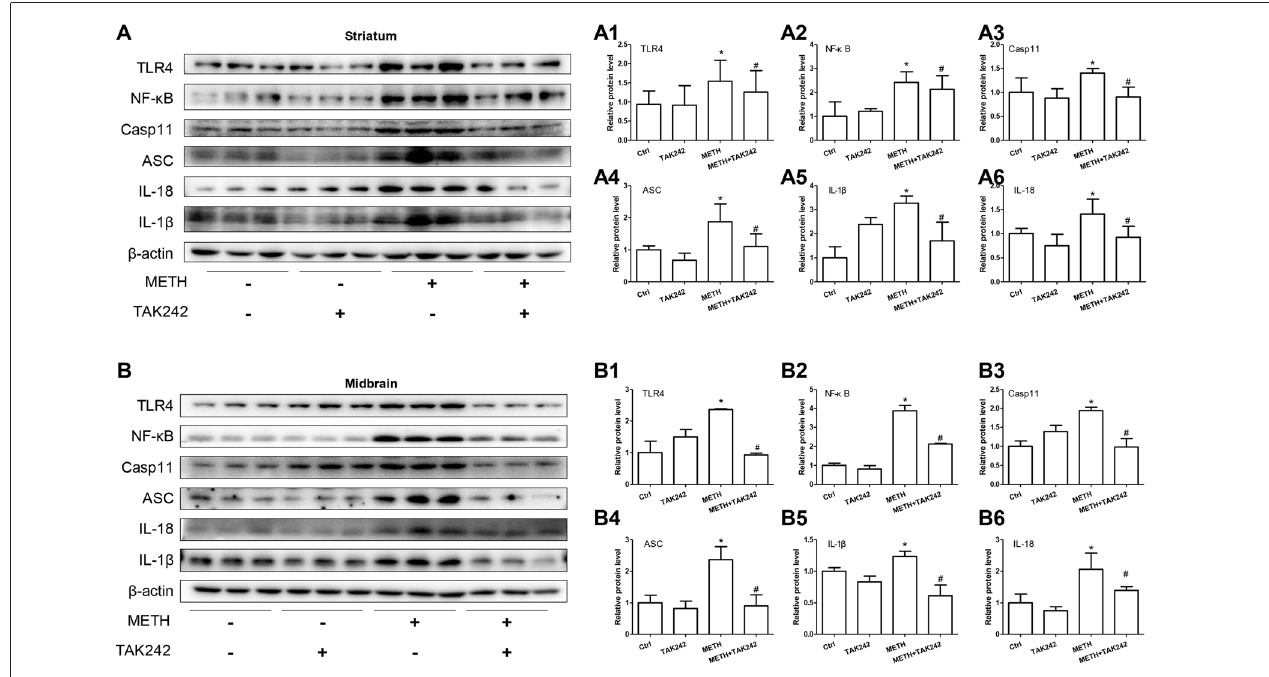
FIGURE 8 | Silencing of TLR4 expression reduces METH-induced IL-1 β and IL-18 expression in vivo . Mice were exposed to saline vehicle, METH, TAK-242, or METH + TAK-242 as described in the methods section and in Figure 4 legend. Striatum and midbrain tissues were harvested at 24 h after the last dosing. Western blot (A,B) and quantitative analyses (A1–A6,B1–B6) were performed to determine TLR4, NF- κ B, Caspase-11, ASC, IL-18 and IL-1 β protein expression. Data are expressed as mean ± SD. ∗ p < 0.05 vs. non-METH-treated group. # p < 0.05 vs. METH-treated group. Data were analyzed with 2 × 2 factorial ANOVA followed by LSD post hoc